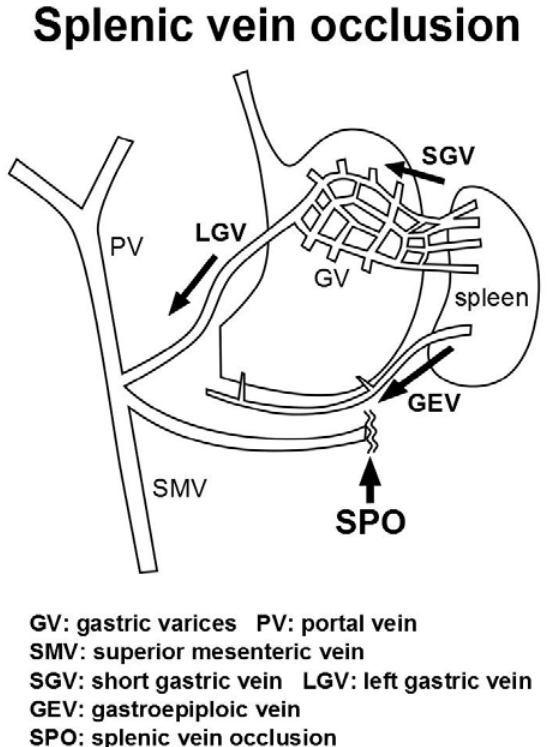
Figure 1. Hemodynamics of gastric varices secondary to splenic vein occlusion (reproduction from Sato et al.